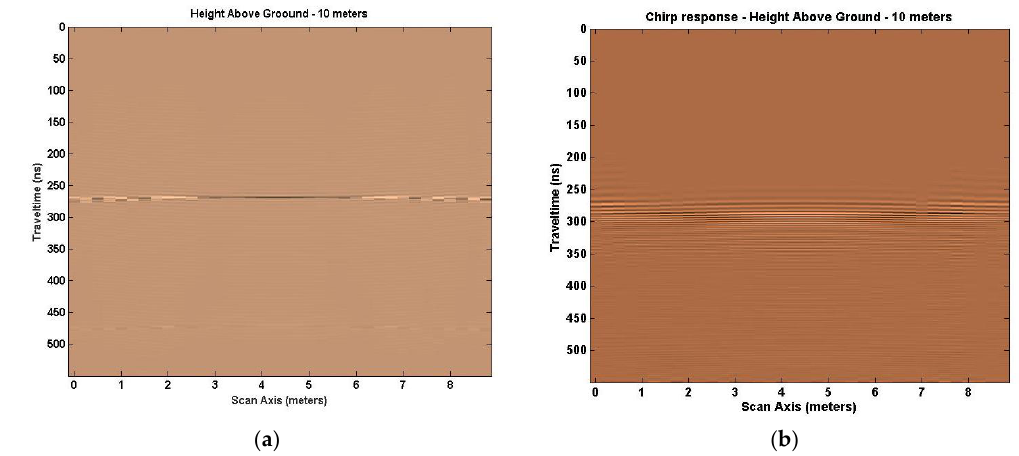
Figure 8. ( a ) Output response of SA1, EM sum of frequency signals with direct arrival and ground bounce signals removed [5]. ( b ) Chirp excitation signal response with the direct arrival and ground bounce signals removed.